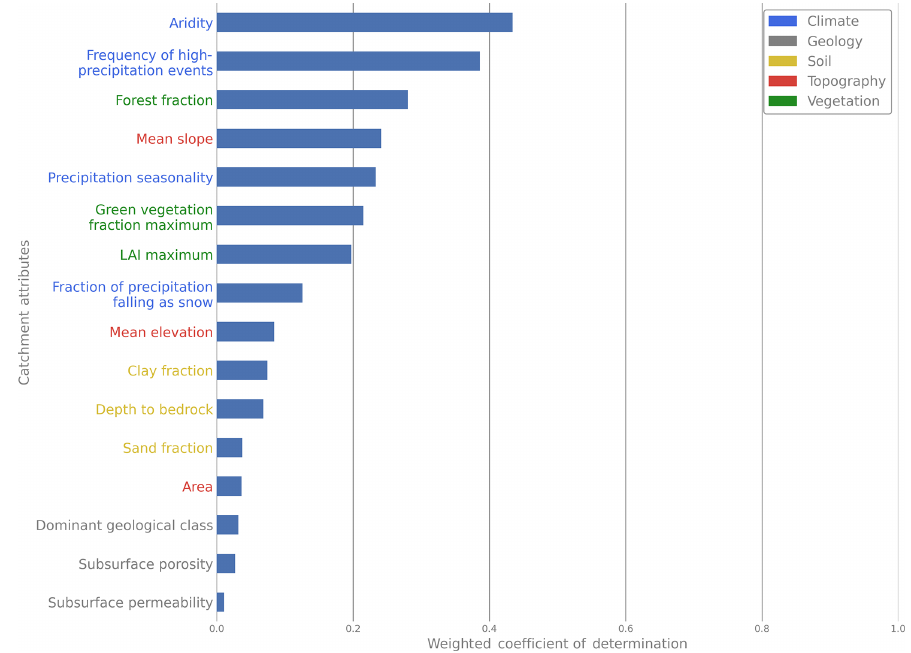
Figure 2. Importance of catchment attributes evaluated by quadratic regression for all considered catchments. Attributes colored according to their catchment attribute class.